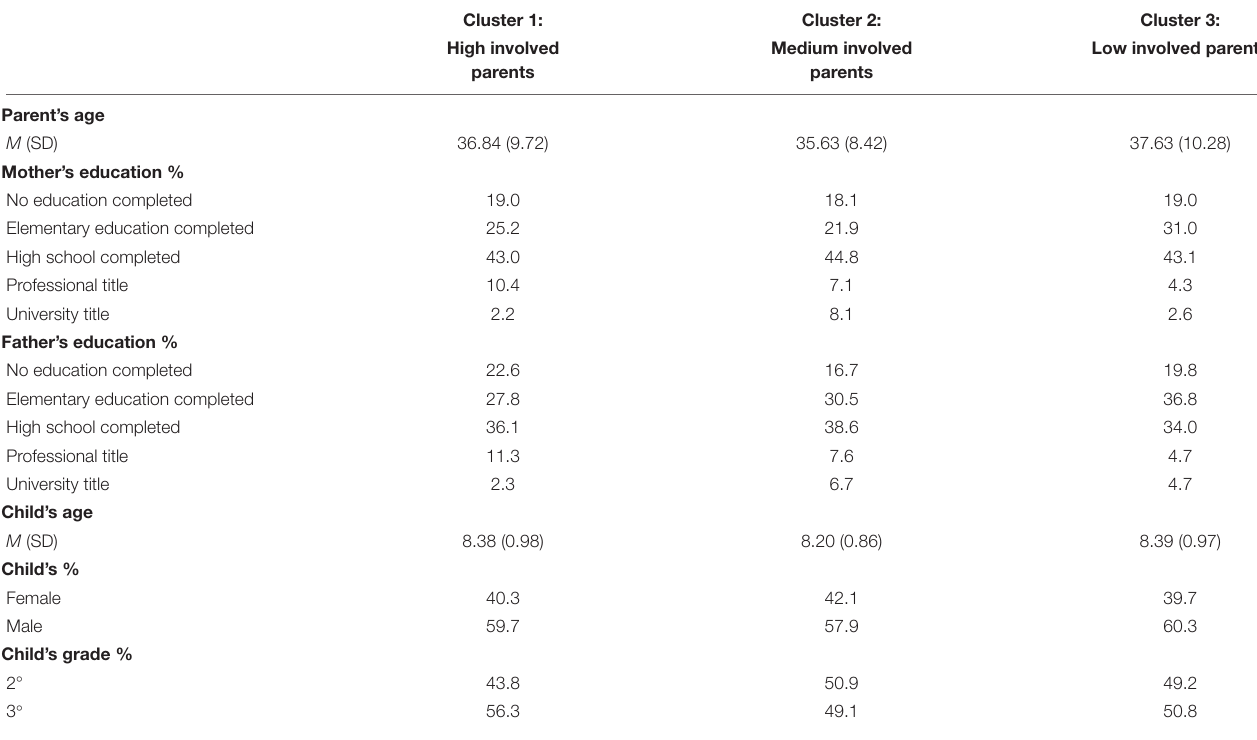
TABLE 1 | Demographic information of the clusters. Cluster 1: Cluster 2: Cluster